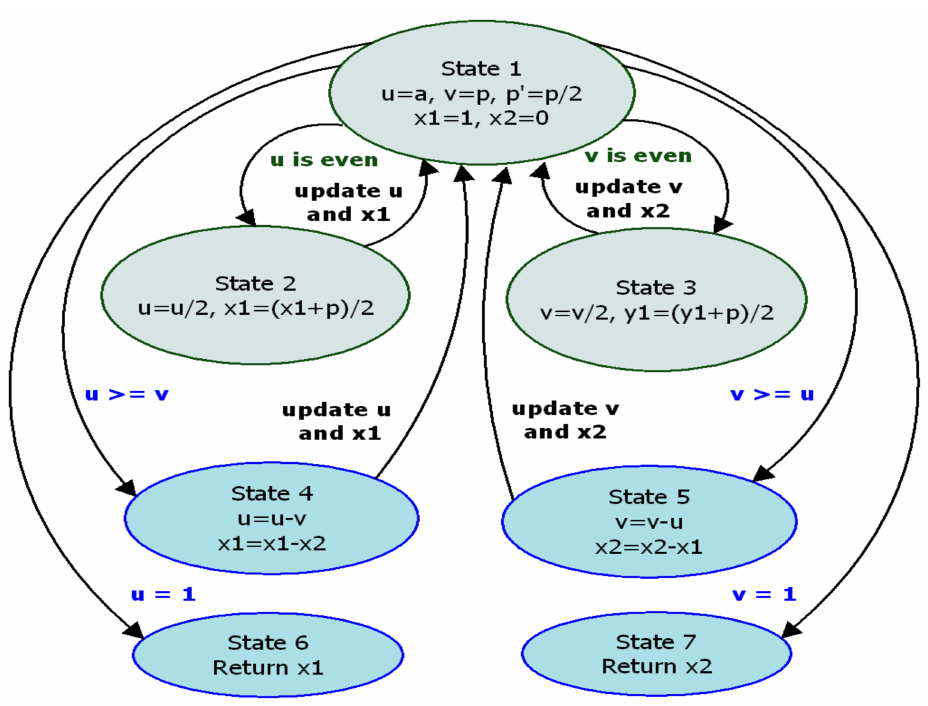
Figure 5. MBEEA state